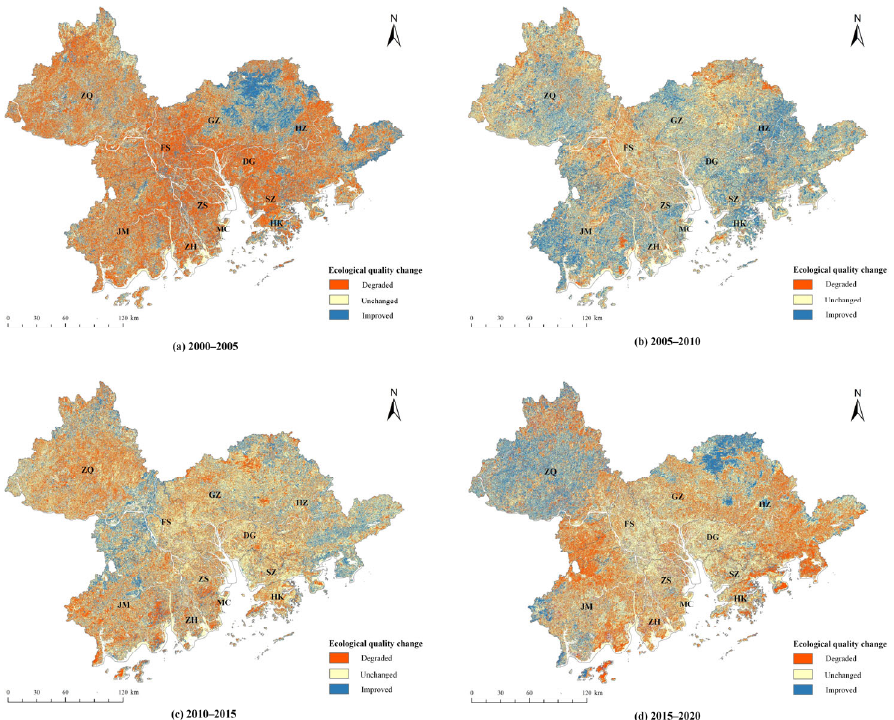
Figure 6. Spatial distribution ecological quality change of the GBA in four time periods.